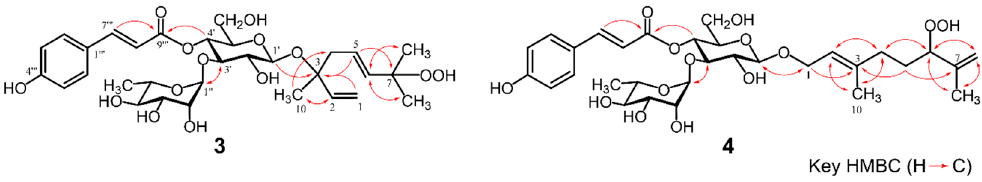
Figure 2. Structures of the new monoterpene glycosides, ligurosides C ( 3 ) and D ( 4 ).